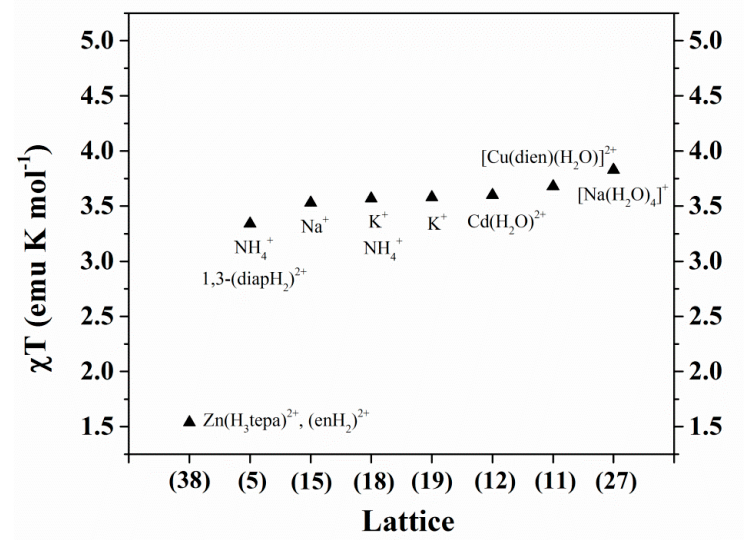
Figure 6. χ T values for each